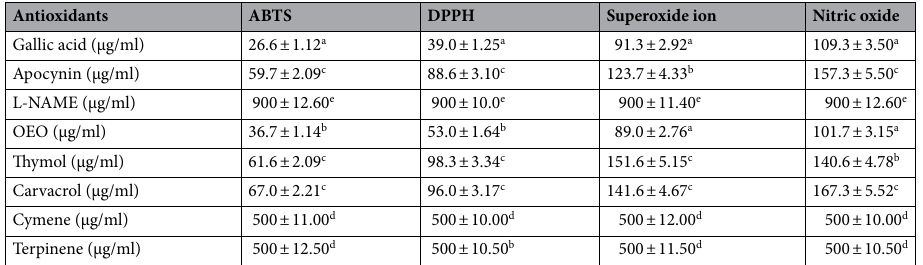
Table 2. The antioxidant capacity of OEO, main components, apocynin, L-Name (positive controls in in-vivo studies) comparison with standard antioxidant gallic acid. The concentrations of OEO that could provide 50% radical or oxidant inhibition (IC 50 ) were calculated from the graph that plotted the radical or the oxidant inhibition percentage against different antioxidant concentrations. The values are expressed as means ± SDs for three replicate experiments. Mean values with different letters within a column are significantly different by the Tukey test at ( p <